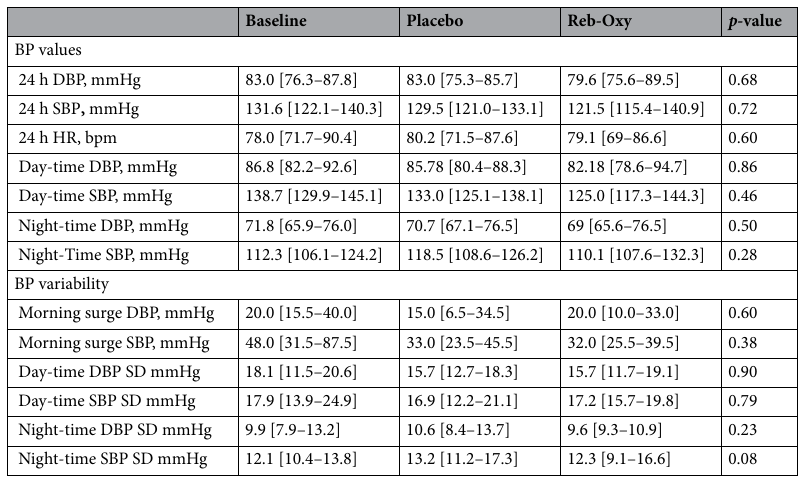
Table 3. Ambulatory blood pressure data at baseline, on placebo, and on reb-oxy drug combination (n = 16). reb–oxy = reboxetine plus oxybutynin; DBP = diastolic blood pressure; SBP = systolic blood pressure. Data are presented as median [interquartile range]. P values compare placebo versus reb-oxy. P -values are calculated by comparing the percent changes from baseline observed after placebo versus reb-oxy.